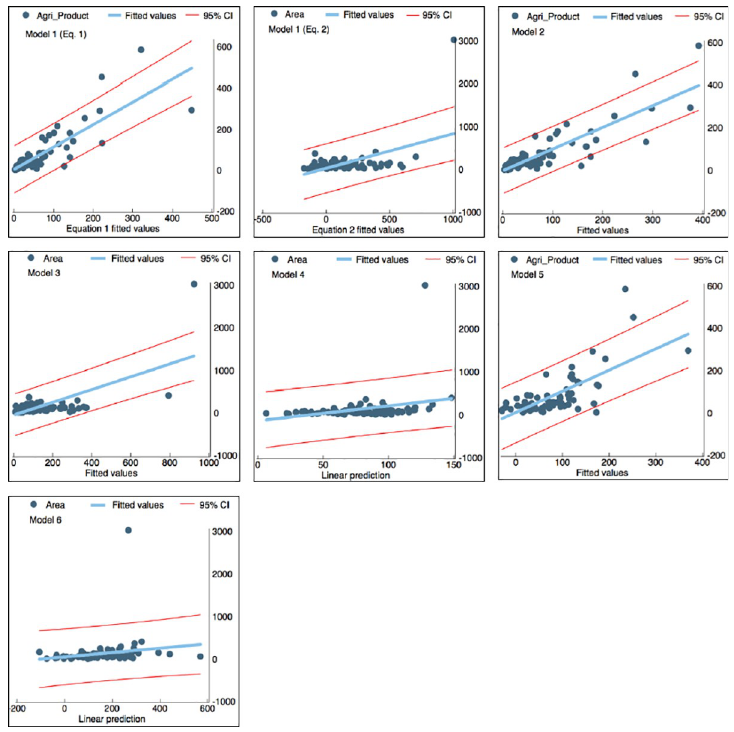
Fig 5. Relationships between observed and fitted values estimated with multivariate regression models for the sub-districts of Bursa.